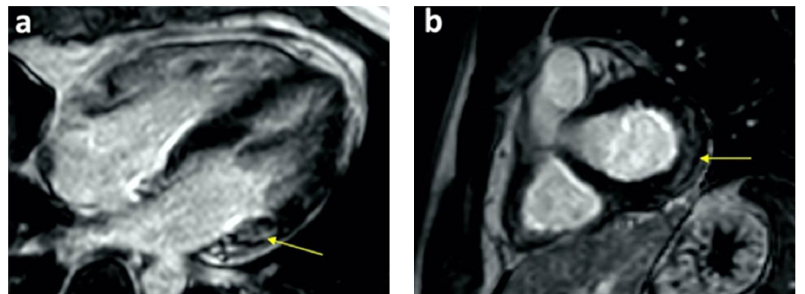
Figure 2. Cardiac MRI PSIR-LGE views show late gadolinium subepicardial enhancement in basal lateral segments in ( a ) four-chamber and ( b ) short-axis views. Reprinted/adapted with permission from Ref. [14]. 2021, Elsevier.